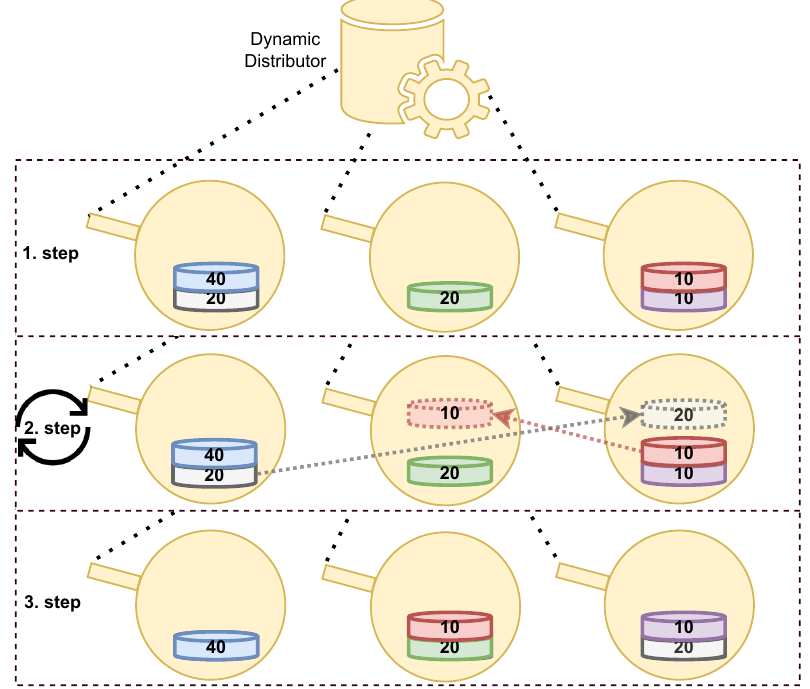
Figure 2. Redistribution of partitioned static